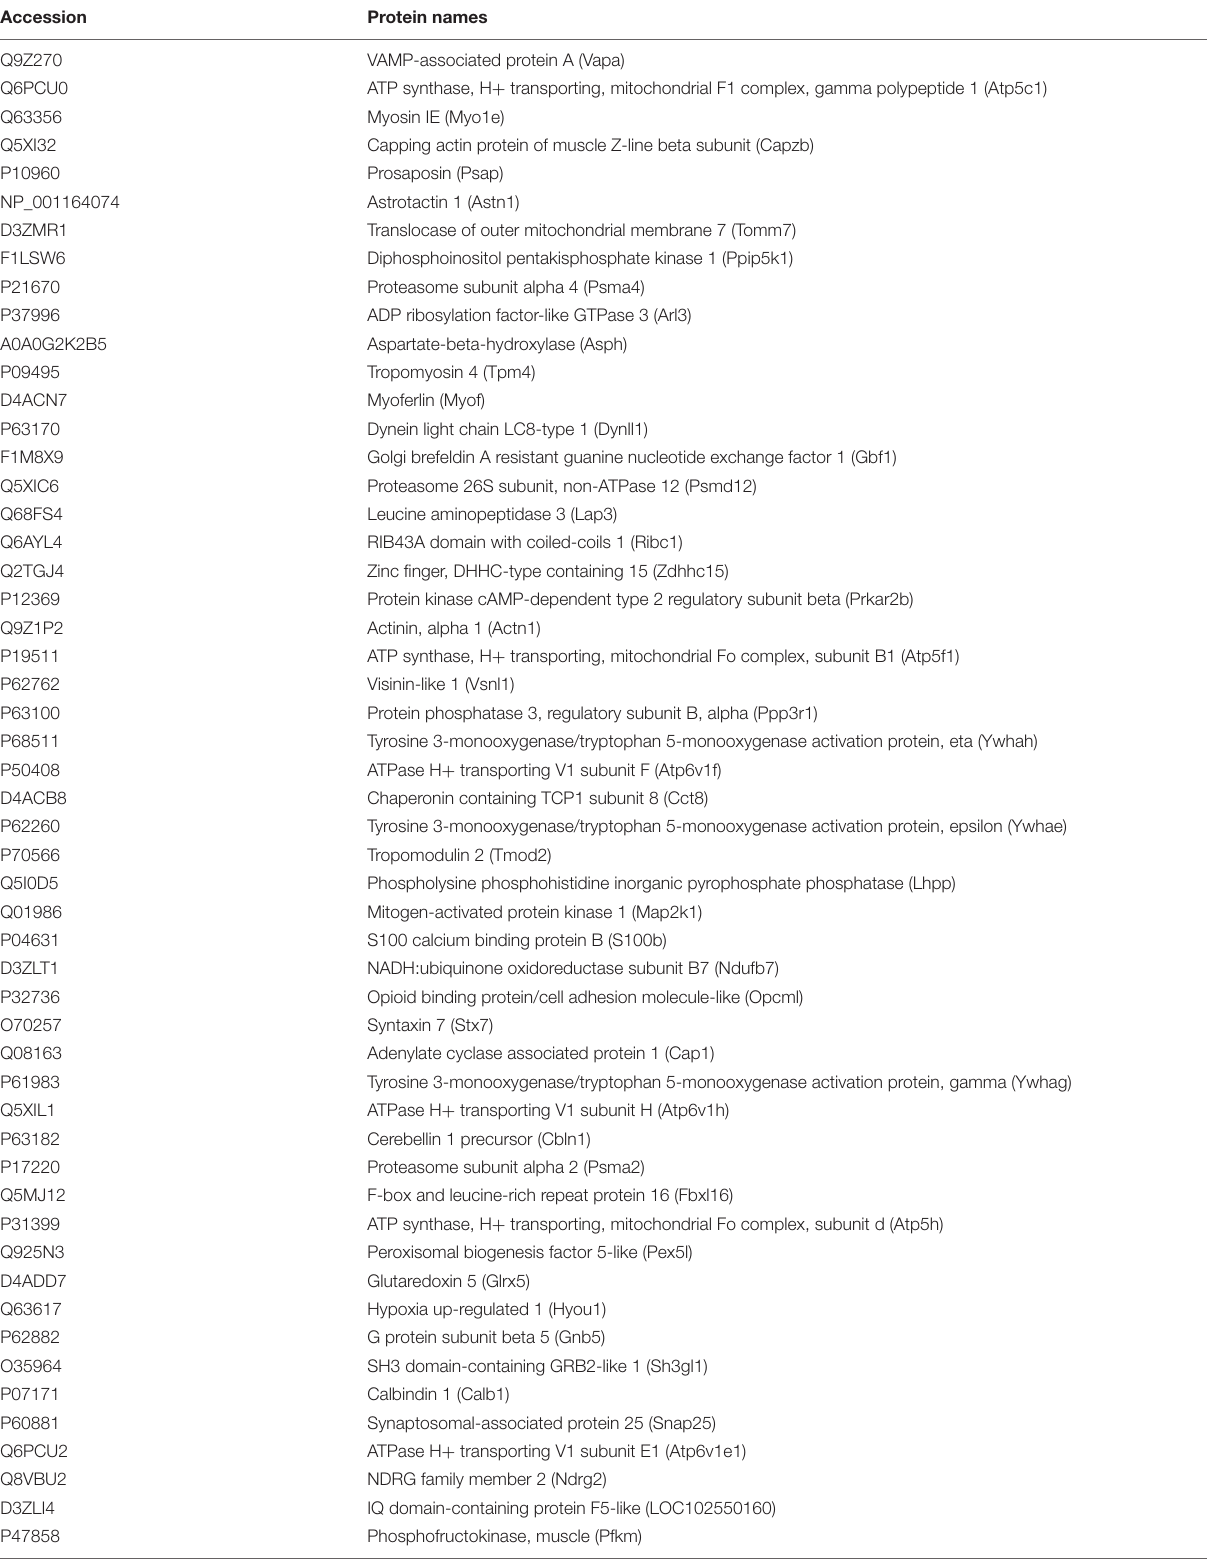
TABLE 2 | Downregulated proteins in the hippocampus of